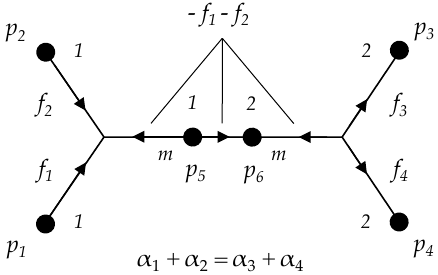
Figure 10 . The (cid:12)gure shows how perturbative ground states participate in 4-point interaction between states localized at p 1 ; p 2 ; p 3 ; p 4 . The gradient (cid:13)ow tree consists of two trivalent trees connected by a gradient (cid:13)ow line between p 5 and p 6 . We have indicated the relevant Morse functions and Morse indices in the picture. The states localized at p 5 and p 6 are lifted by instanton corrections and develop a mass m (cid:24) M Inst . In the 4d e(cid:11)ective (cid:12)eld theory this gives rise to a 4-point